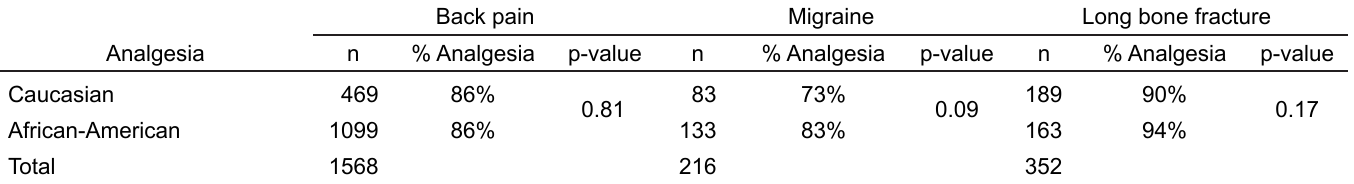
Table 3a. Percent of patients receiving any analgesia by diagnosis and race.